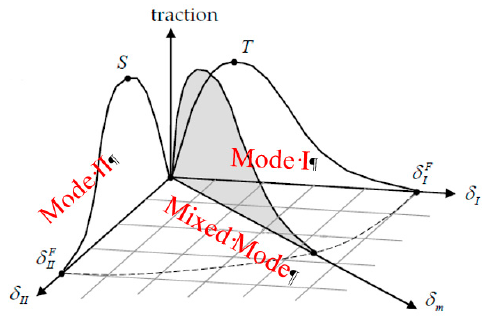
Figure 7. Mixed-mode interactions [42].